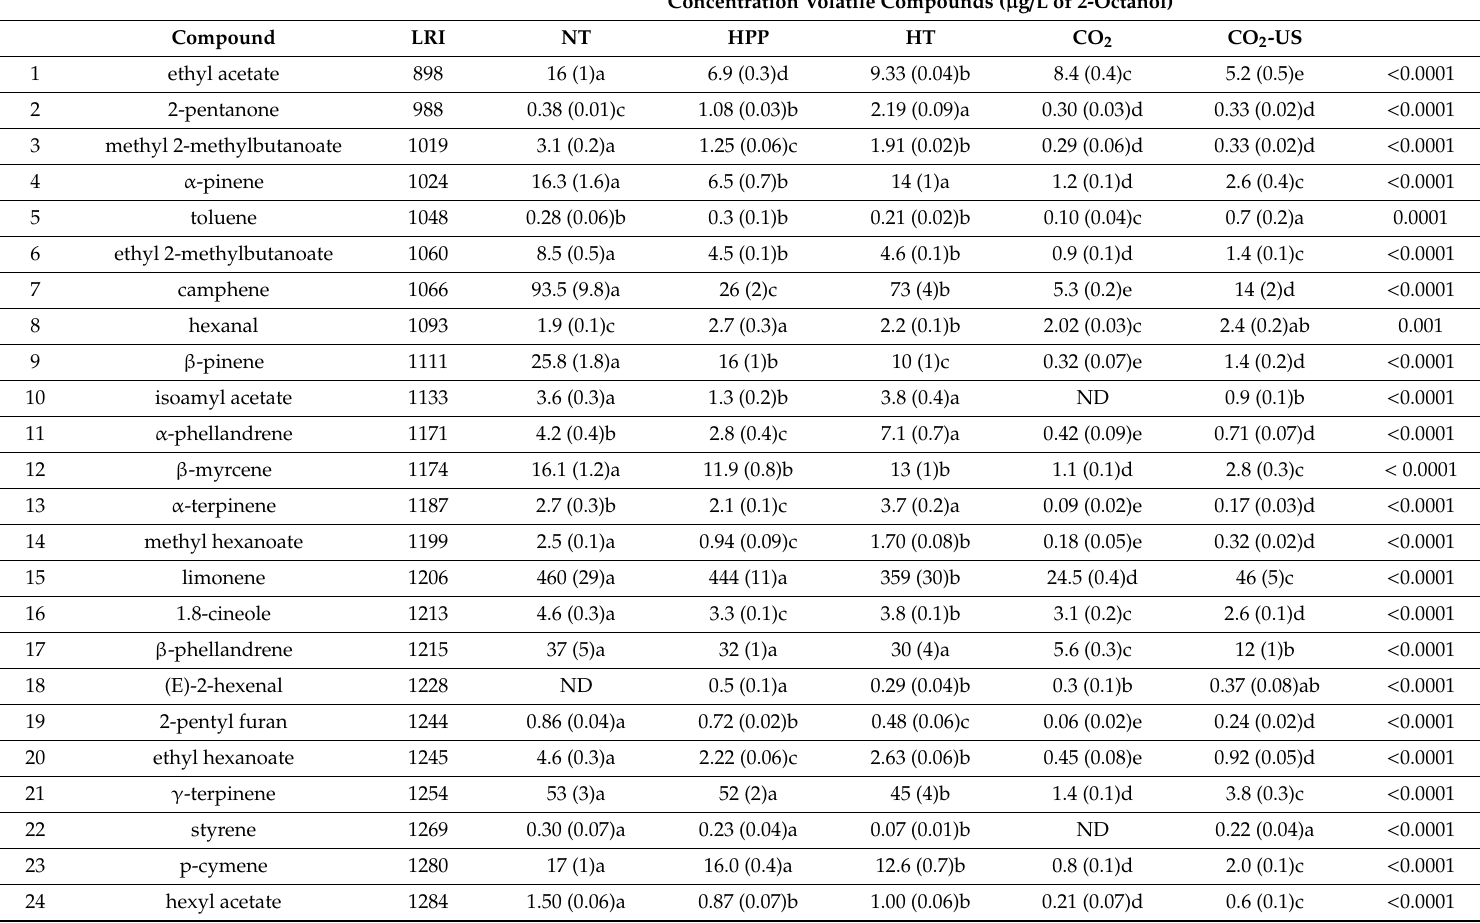
Table 3. Volatile compounds identified in the pomegranate juices at t = 0 of storage: For each compound, listed in order of linear retention index (LRI), we give the mean values related to the five preservation treatments with standard deviations in brackets and the p -values ( p ) of one-way ANOVA applied to check for preservation treatment e ff